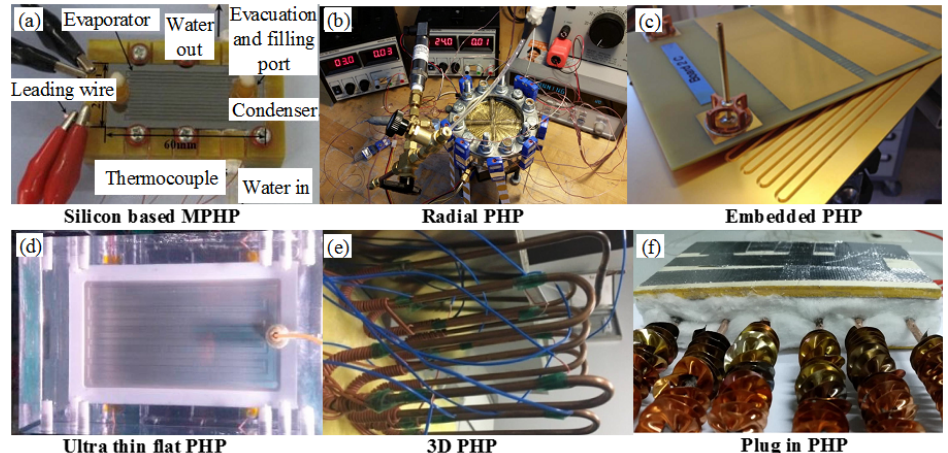
Figure 6. Cooling arrangement of PHP: ( a ) Silicon based MPHP [74]. Qu et al. (2012); ( b ) Radial